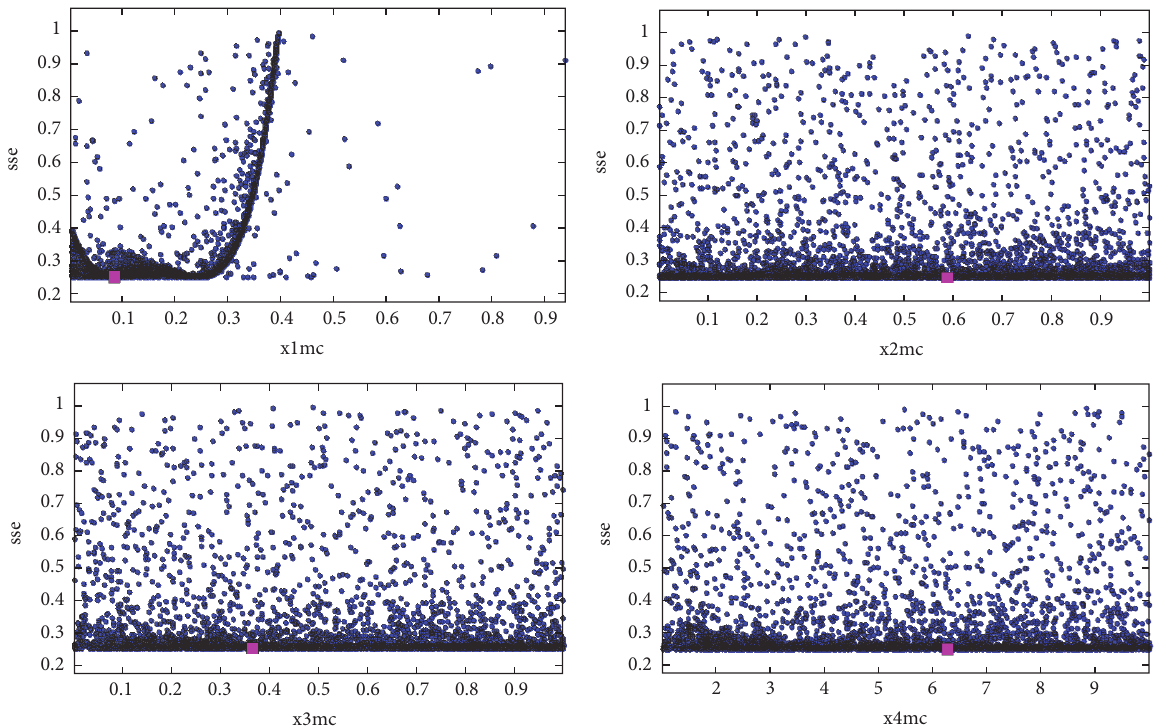
Figure 1: Dotty plots of objective function (x1mc- 𝜃 𝑟 , x 2 mc- 𝜃 𝑠 , x 3 mc- 𝛼 , x 4 mc- 𝑛 ).